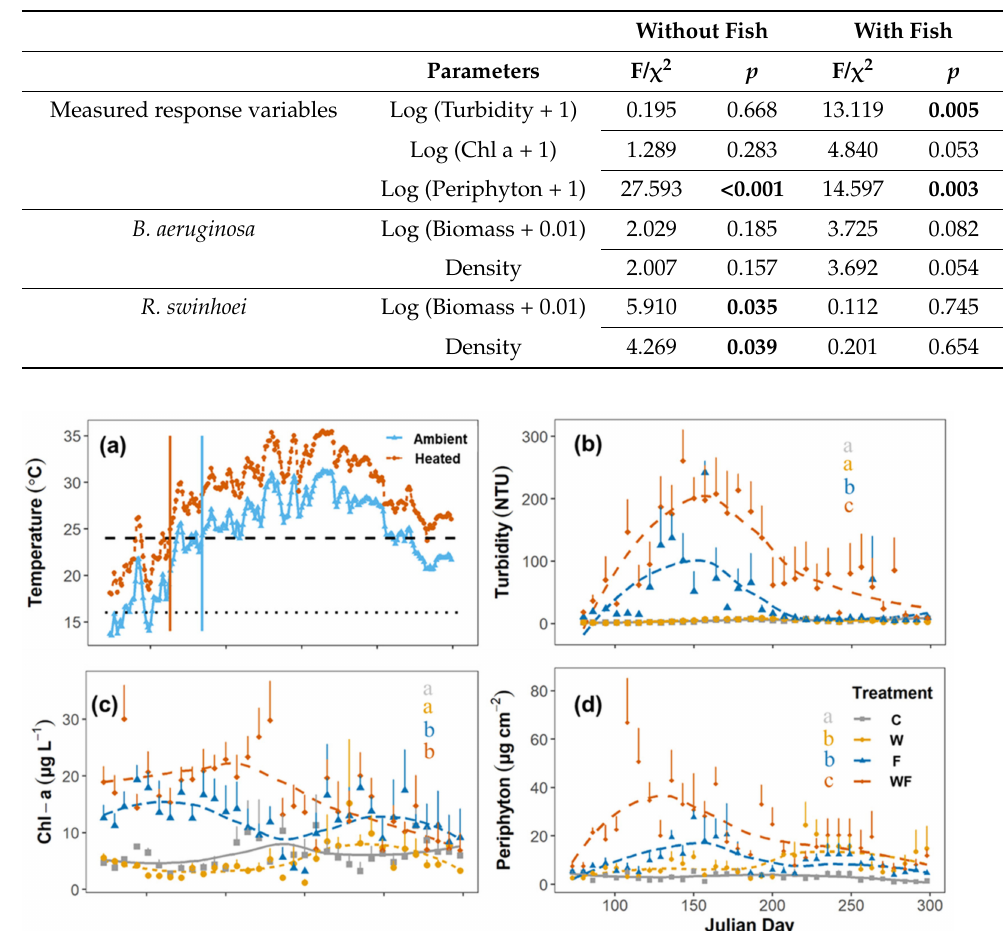
Figure 1. Daily average temperature ( a ), water turbidity ( b ), and Chl-a concentration in the water column ( c ) and periphyton ( d ) changed over time in different treatments. In panel ( a ), the horizontal dotted and dashed lines indicate temperatures of 16 ◦ C and 24 ◦ C, respectively. When the average temperature started to go above 24 ◦ C, the days were 113 and 134 for the warming and ambient treatments, and these are indicated by vertical red and blue lines, respectively. The curves were fitted from the LOESS model in R package ggplot2. Panels ( b – d ) share the same legend. Vertical bars are standard errors. Small letters indicate significant difference between the four treatments. C for control, W for warming without fish, F for fish present alone and WF for warming with